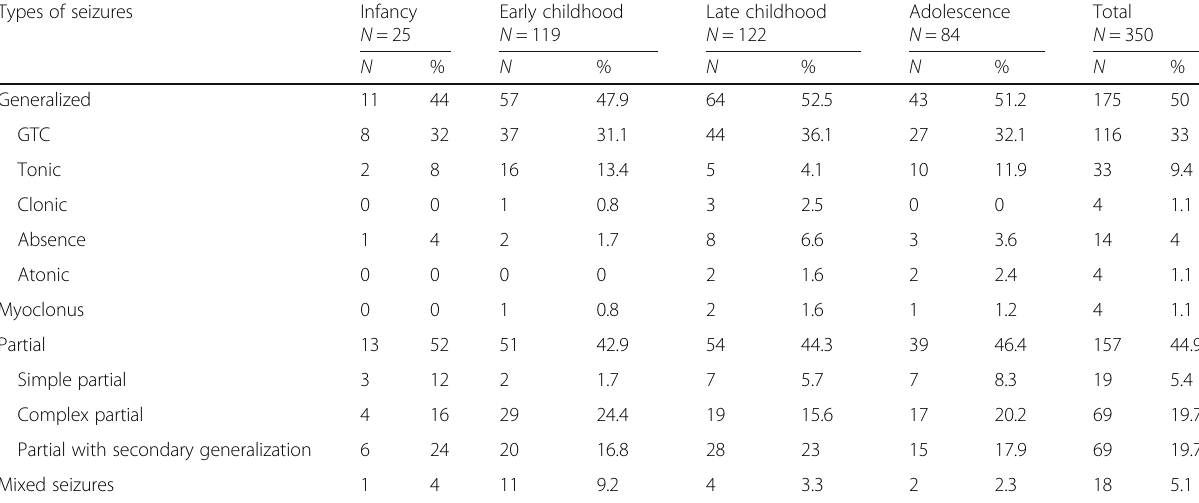
Table 5 Rate of different types of seizures among the studied epileptic groups Types of seizures